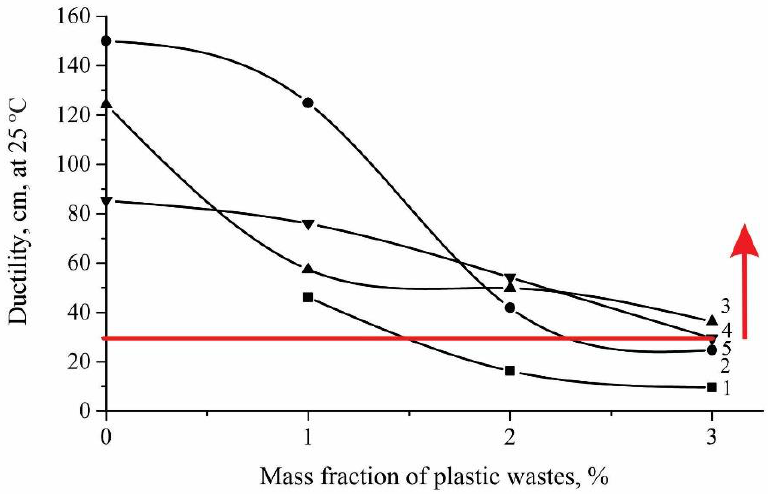
Figure 5. Change in ductility with polymer waste concentrations. 1—without SBS; 2—SBS 1%; 3—SBS 2%; 4—SBS 3%; 5—according to Standard.